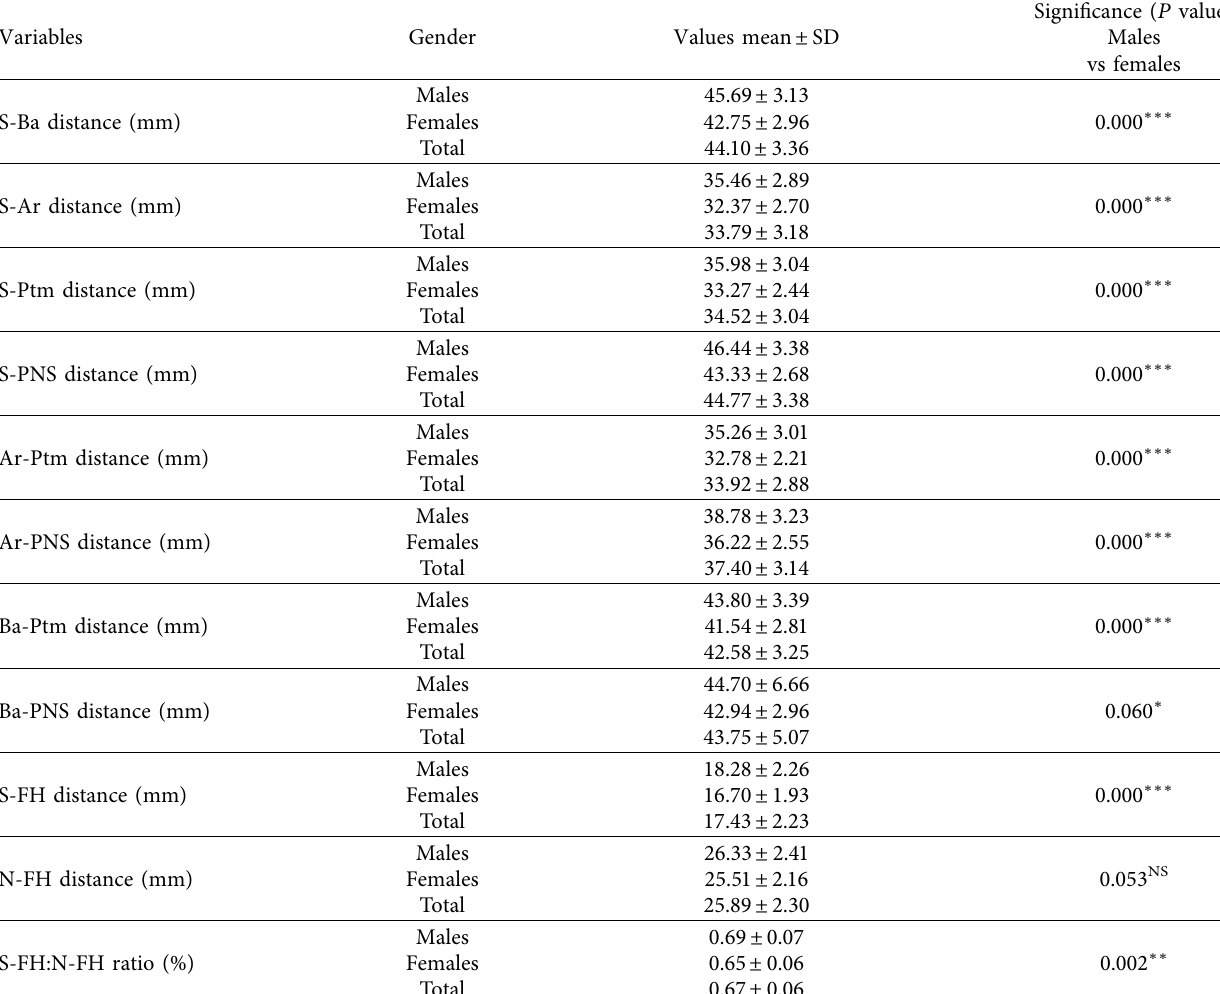
Table 2: Various linear parameters and ratio used to determine the normal vertical positions of S and N points.